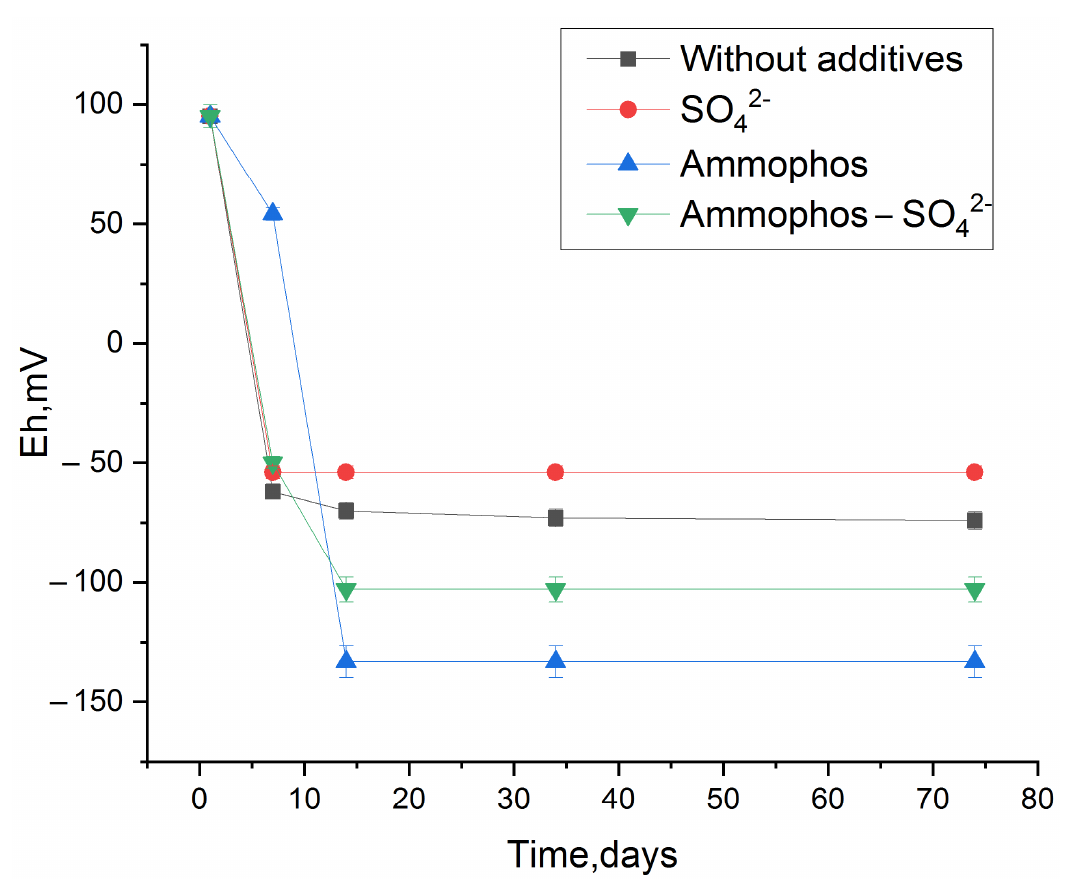
Figure 6. Reduction in redox potential of the bottom sediment system when stimulated with Amophos and sulfate.